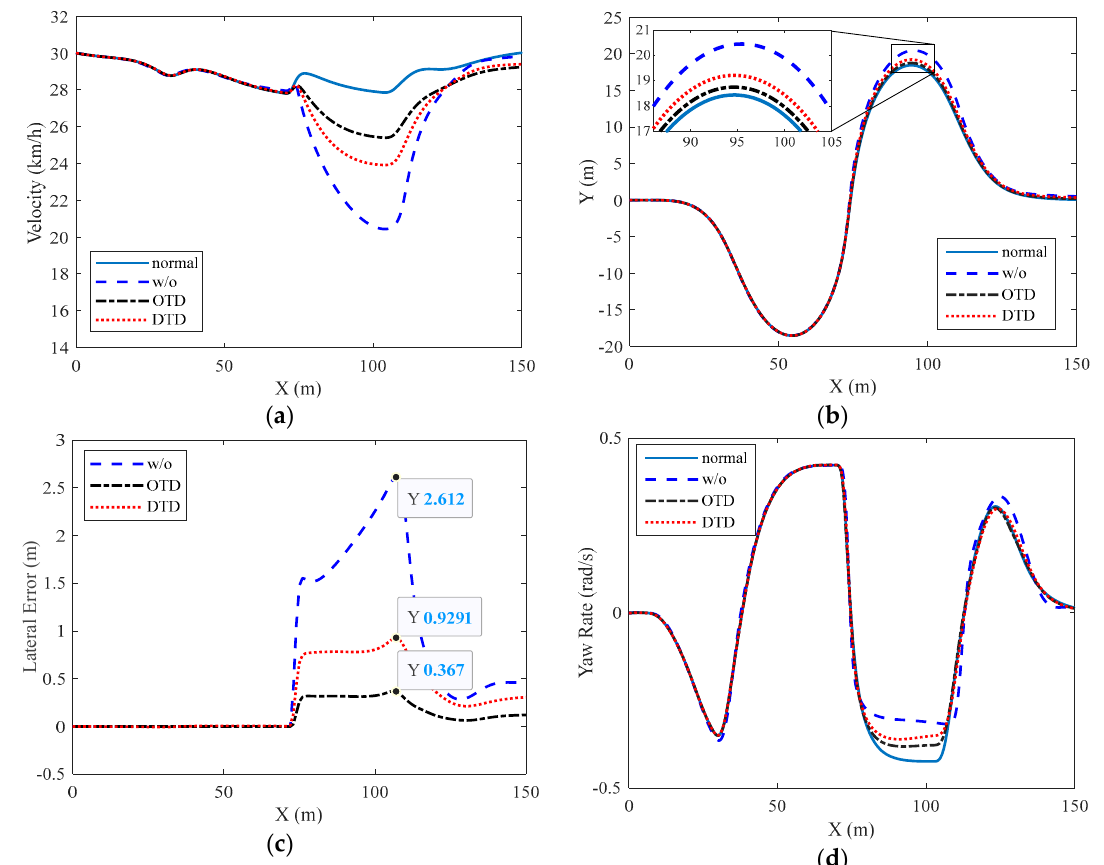
Figure 6. State comparation of different vehicles. ( a ) Vehicle velocity; ( b ) vehicle trajectory; ( c ) lateral displacement error relative to normal vehicle; ( d ) vehicle yaw rate.